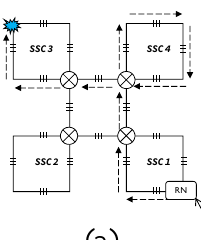
Figure 5. (a) Single-link failure; (b) Self-healing for one link